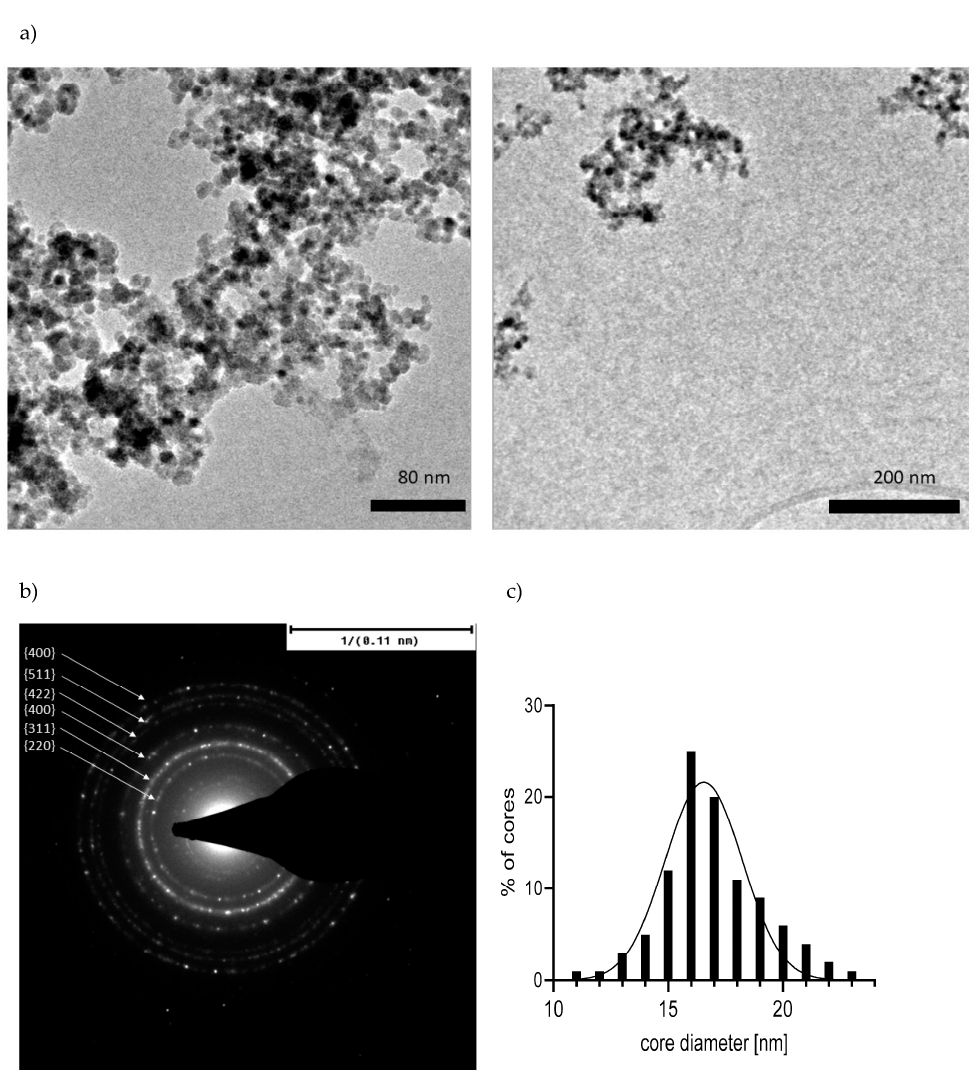
Int. J. Mol. Sci. 2021 , 22 , x FOR PEER REVIEW Figure 2. ( a ) TEM images of SPION HAp ; ( b ) selected area diffraction; ( c ) core size distribution.